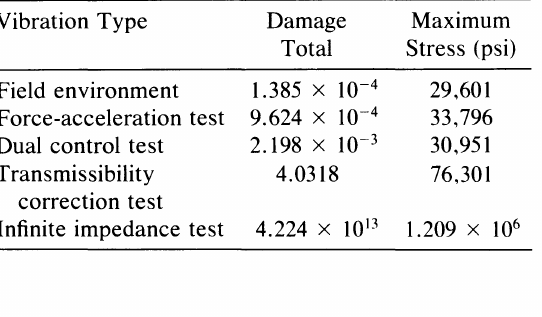
Table 3. Cumulative Damage Results and Maximum Bending Stress for Subsystem